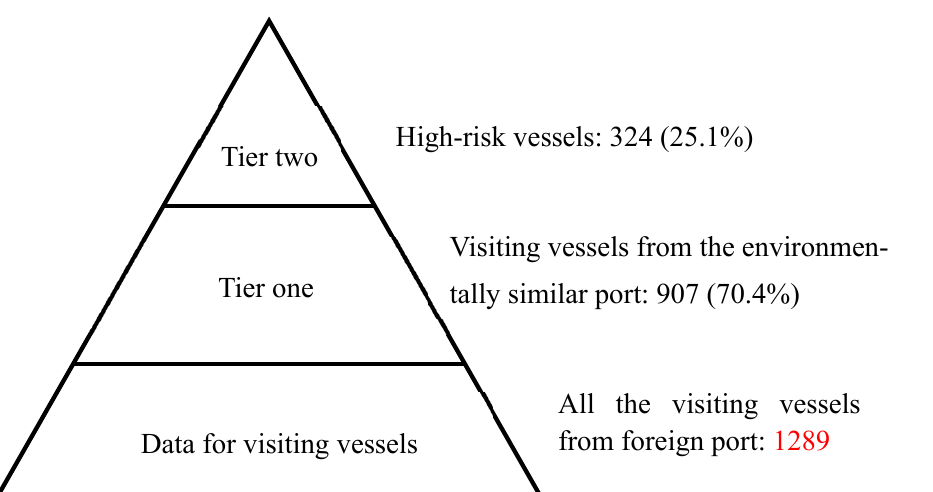
Figure 4. Location of the donor ports with similar environments to the port of Riga. The red and green solid circles represent ports with a risk score of 6 and 5, respectively, based on the criteria set in Table 1.